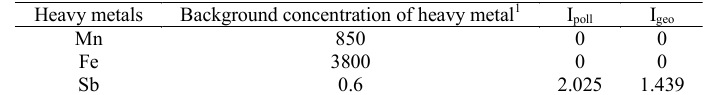
Table 8: Muller’s geochemical index, Karbassi modified geochemical accumulation index and contamination factor of studied soils (Karbassi et al., 2008) Heavy metals